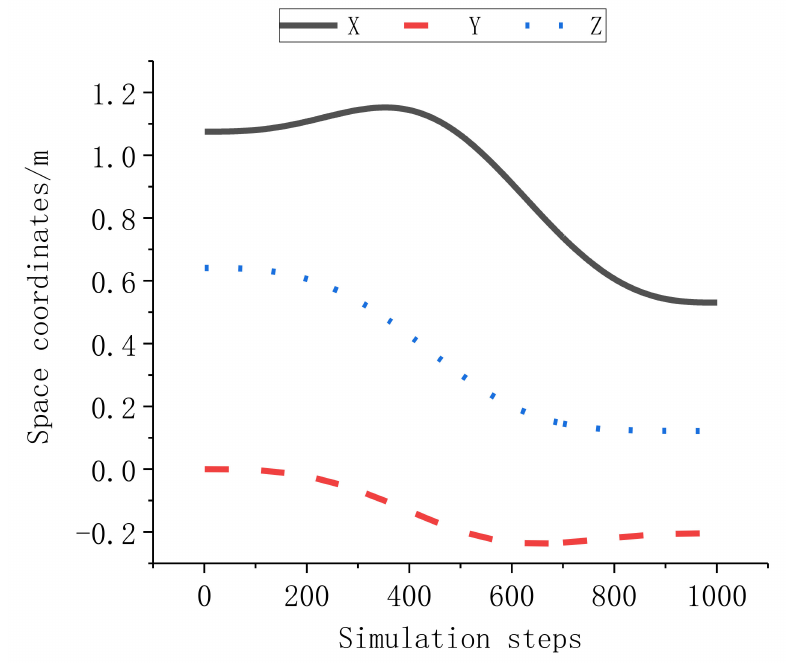
Figure 8. End displacement curve of the